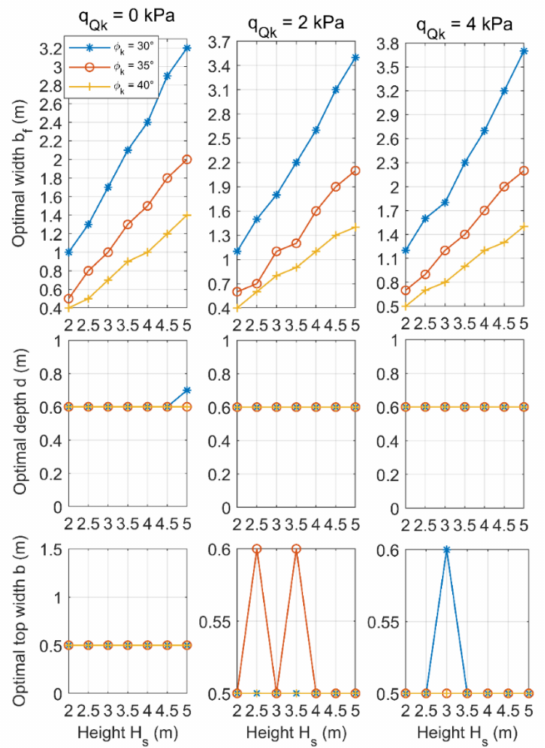
Figure 11. Optimal design for k = 1, β = 20 ◦ and γ = 18 kN/m 3